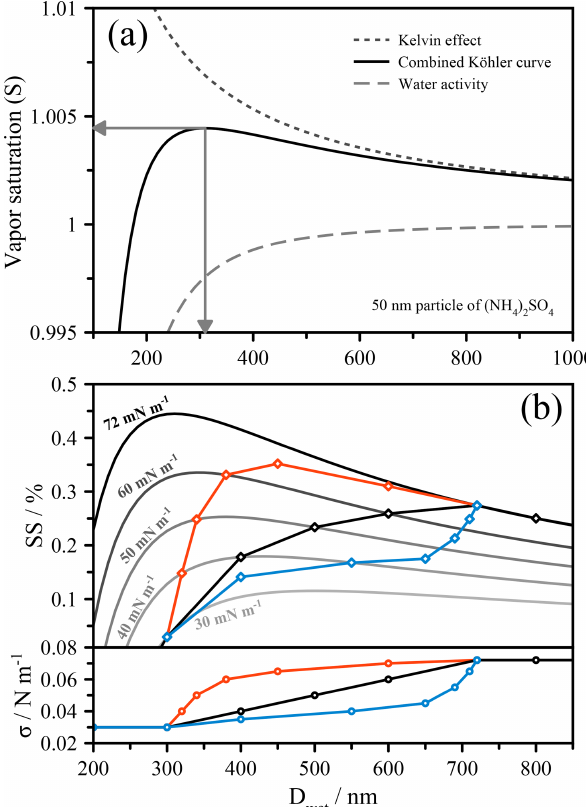
Figure 1. (a) Köhler curve construction from the combination of the water activity term and the Kelvin effect, shown here for 50nm par- ticles of ammonium sulfate. The arrows indicate the critical super- saturation (SS crit ) and the critical wet activation diameter ( D crit ). (b) Köhler curves (NB. SS = (S − 1 ) × 100%) of varying fixed sur- face tension values for 50nm (dry diameter) particles with water activity treated as an ammonium sulfate solution. A schematic lin- ear dependence of surface tension on droplet diameter is shown in black, and the Köhler curve construction that takes into account the change in surface tension is shown in bold and with diamond symbols. Additional surface tension dependencies are shown in red, which exhibits activation at σ<σ w , and in blue, which shows a dra- matic increase in the critical wet